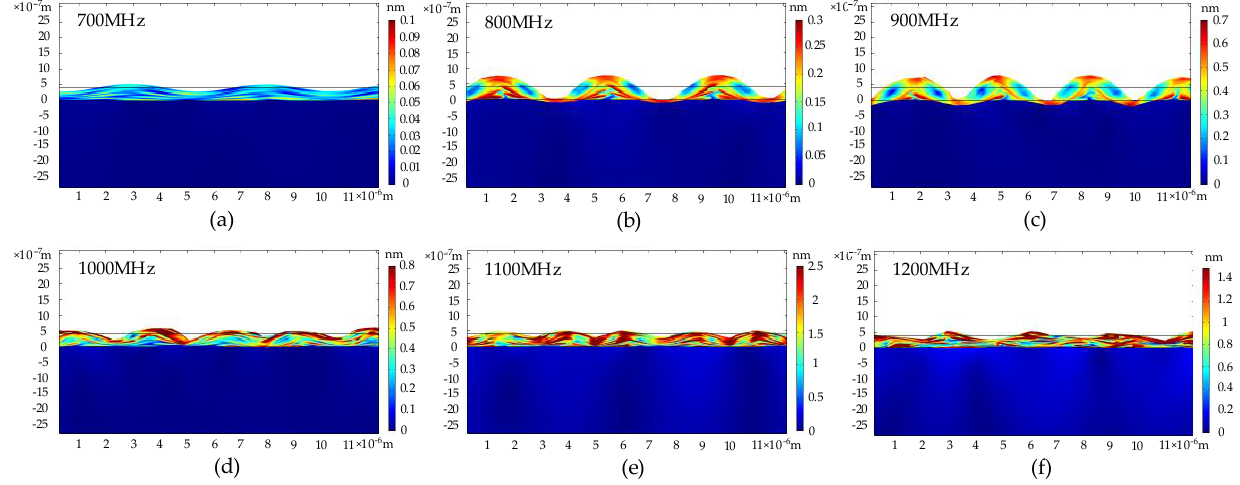
Figure 7. Phonograph displacement field in different resonant frequencies of the phonon piezoelectric device of the NV center. ( a ) 700 MHz; ( b ) 800 MHz; ( c ) 900 MHz; ( d ) 1000 MHz; ( e ) 1100 MHz; ( f ) 1200 MHz.